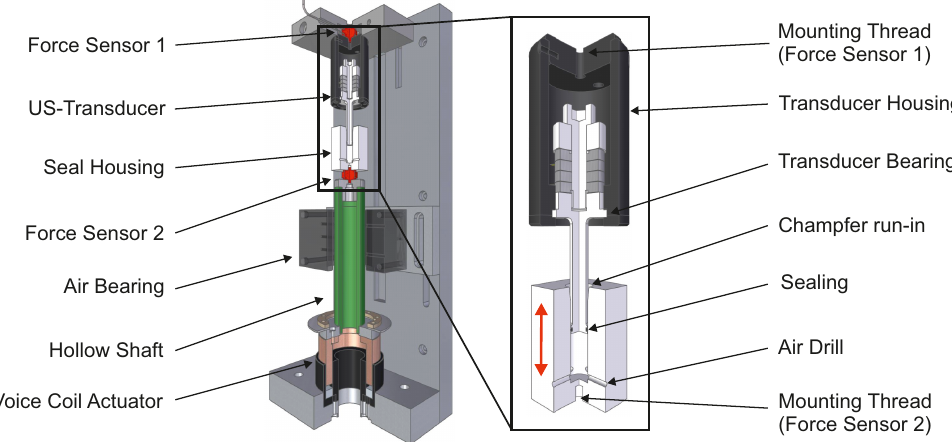
Figure 1. Topology of the linear tribometer. Sealing holder design for piston sealing and the corresponding sonotrode tip